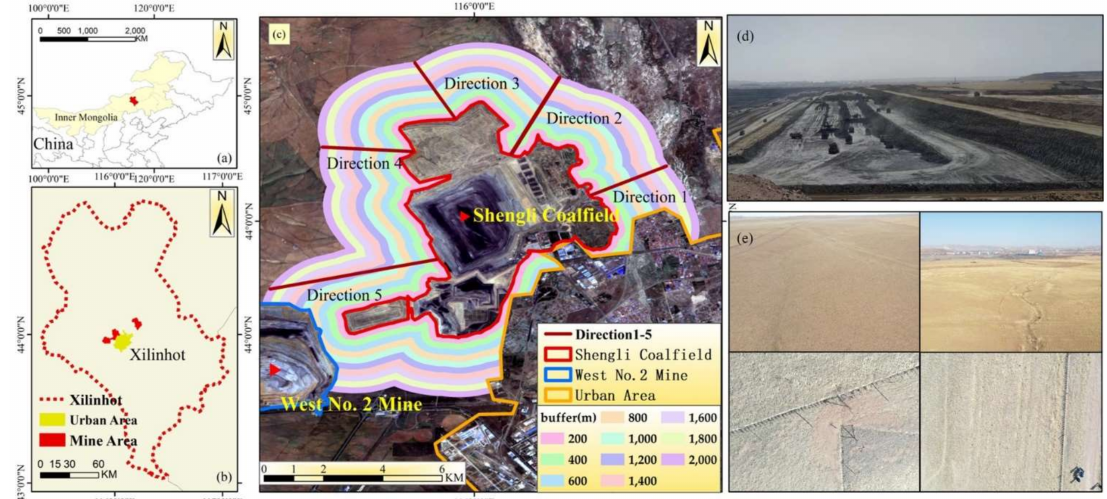
Figure 3. The geographical location of Shengli Coalfield in Xilinhot, Inner Mongolia, China. ( a ) Location of Xilinhot in China; ( b ) boundaries of the mine and urban areas in Xilinhot; ( c ) ex- tent of the study area; ( d ) drone image of the mining area; ( e ) drone images of the grassland.